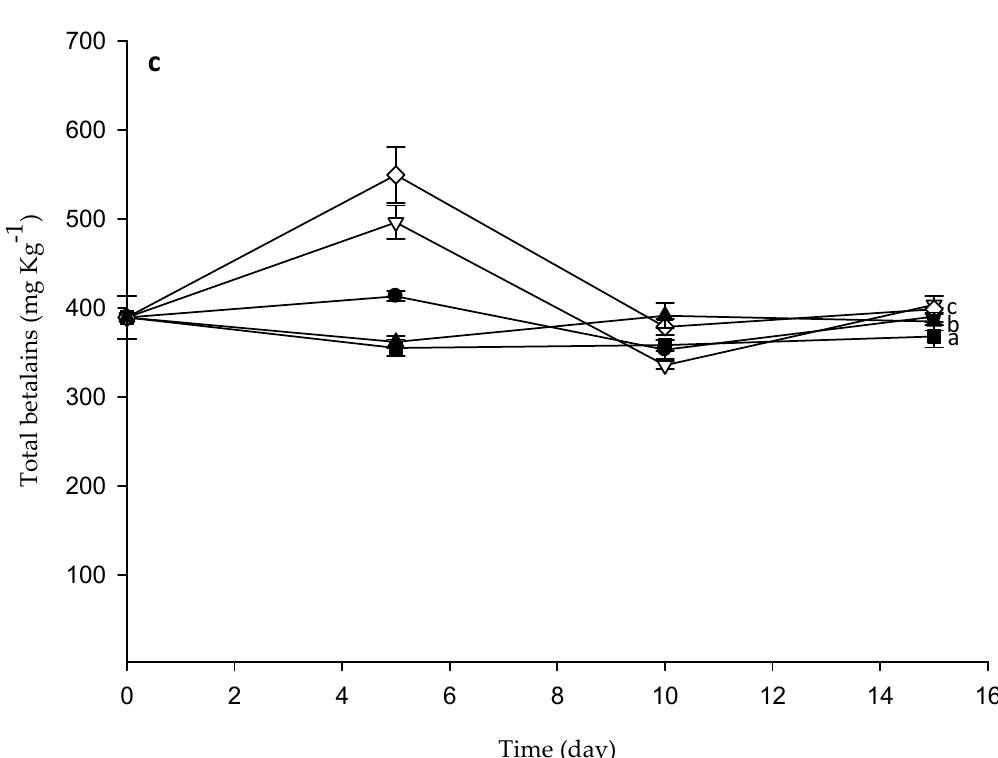
Figure 4. Determination of betacyanins, ( a ), betaxanthins ( b ), and total betalains ( c ) in the pulp of pitaya during storage at 10 °C and relative humidity (RH) of 80 % . Data are the mean and their standard deviation ( n = 9) (See Table 2 for treatment identification). Different letters among traces mean significant differences ( p < 0.05).